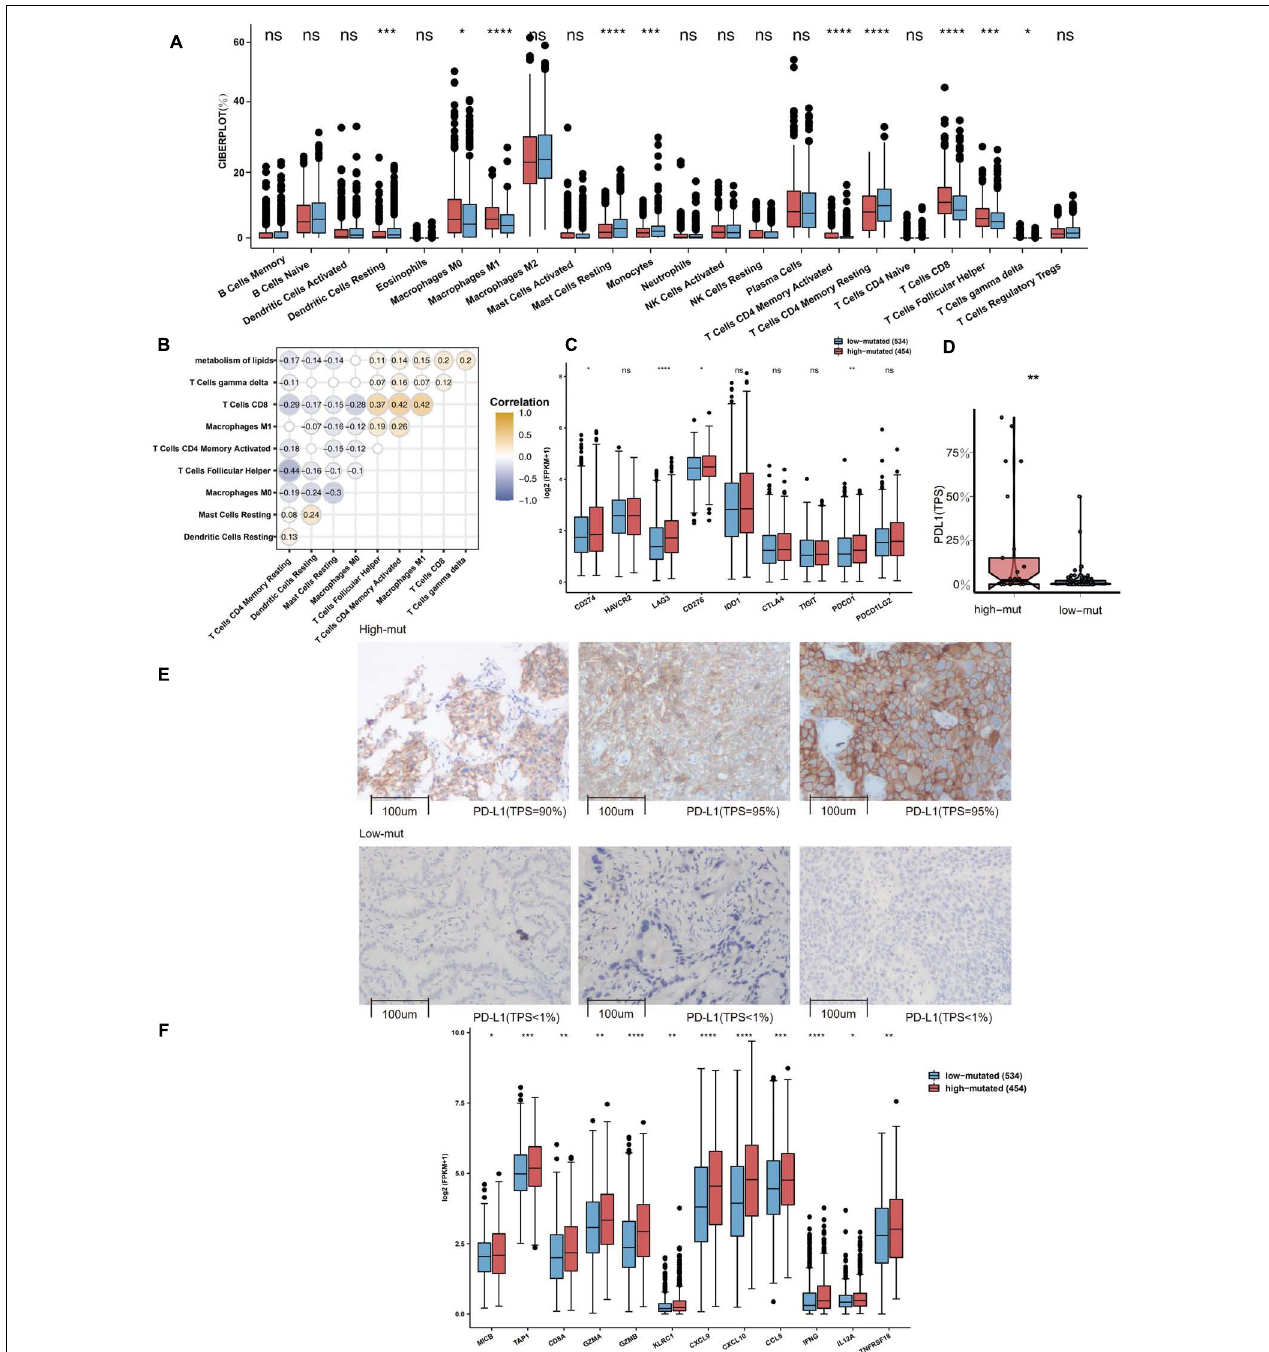
FIGURE 3 | (A) Comparison of the fractions of 22 types of immune cells as estimated by the CIBERSORT algorithm between the high and low mutation groups in the TCGA cohort. (B) The correlations between the number of mutations in the lipid metabolism pathway and the proportions of immune cells. (C) Comparison of the expression of immune-related genes between the high and low mutation groups in the TCGA cohort. (D) Comparison of the expression of PD-L1 (TPS) between the high and low mutation groups in the Local-NSCLC cohort. (E) The typical cases for each TPS level between the high (three samples; high PD-L1 TPS) and low mutation (three samples; no PD-L1 TPS) groups in the Local-NSCLC. Using HE and PD-L1 stained slides, we manually assessed the number of tumor cells, the sample size (diameter), the crush rate with a cut-off value of < 1% (no PD-L1 TPS), 1–50% (low PD-L1 TPS), 50% < (high PD-L1 TPS), and the TPS for each biopsy sample using the slide that contained the most tumor cells. The TPS level was evaluated by pathologists who completed training courses in TPS estimation. (F) Heatmap depicting the mean differences in the expression of proinflammatory and antigen presentation genes between the high and low mutation groups in the TCGA cohort. Each square represents the fold change or the mean difference in the expression of these genes between the high and low mutation groups in the TCGA cohort. Red indicates upregulation.